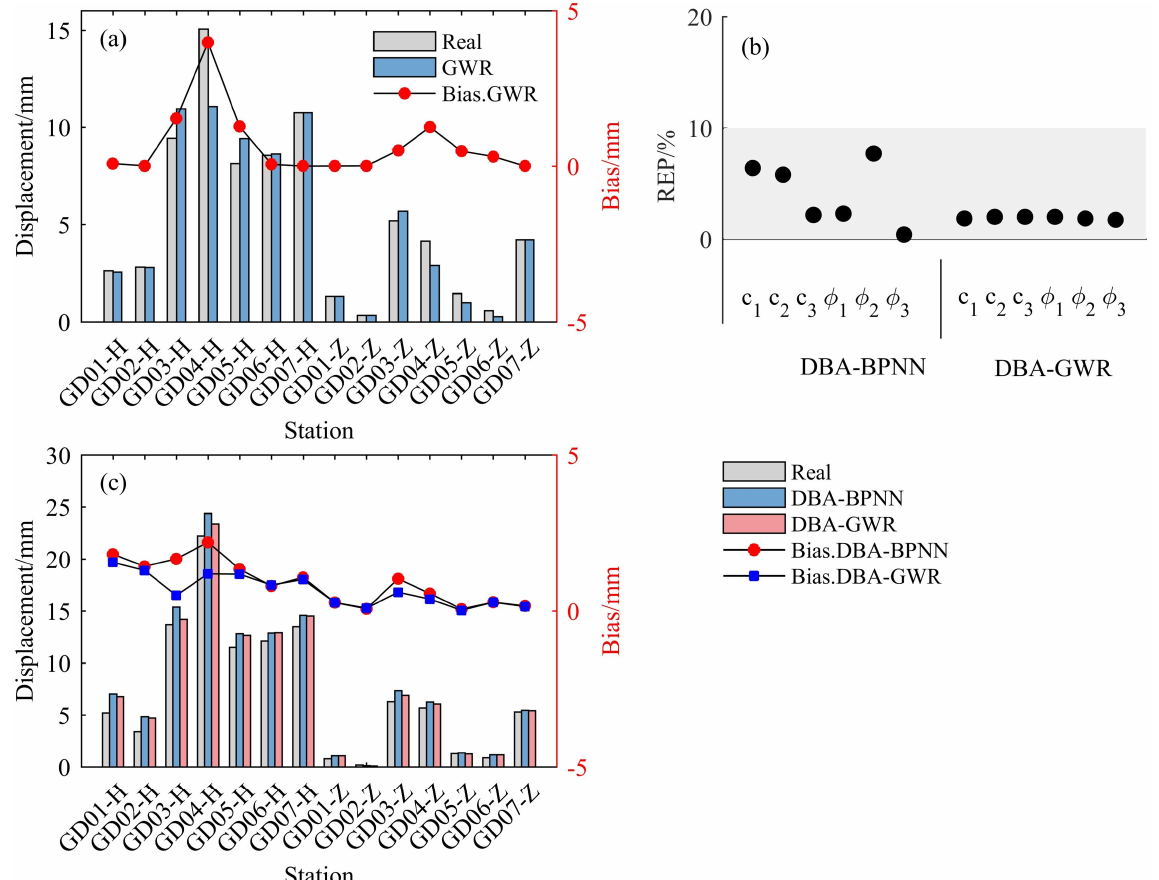
Figure 11. ( a ) Comparison between the fitted values from the GWR and the measured values, ( b ) accuracy of the back-analysis results for different methods, and ( c ) comparison of the simulated and measured results.